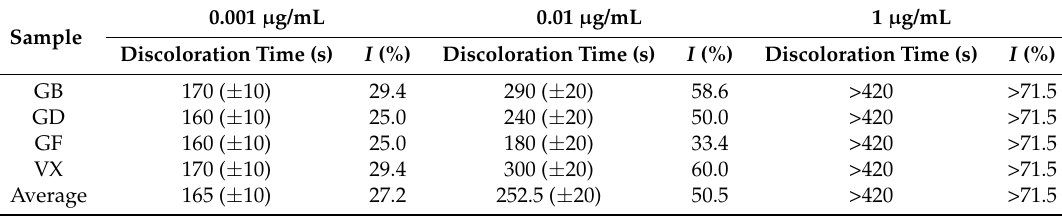
Table 1. Experimental data acquired during the determination of the inhibitor concentrations: the indicator zone discoloration time and the corresponding inhibition efficiency (I) of major nerve agents. The data in the table are mean values (rounded to tens) of 4 measurements, the results were independently evaluated by at least three